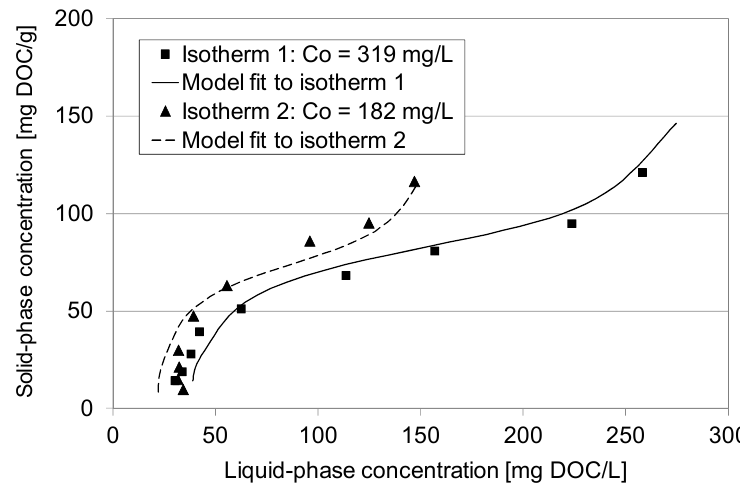
Figure 2. Overall isotherms of pre-treated HTC spent grains PW and fit of the Ideal Adsorbed Solution Theory (IAST) model.